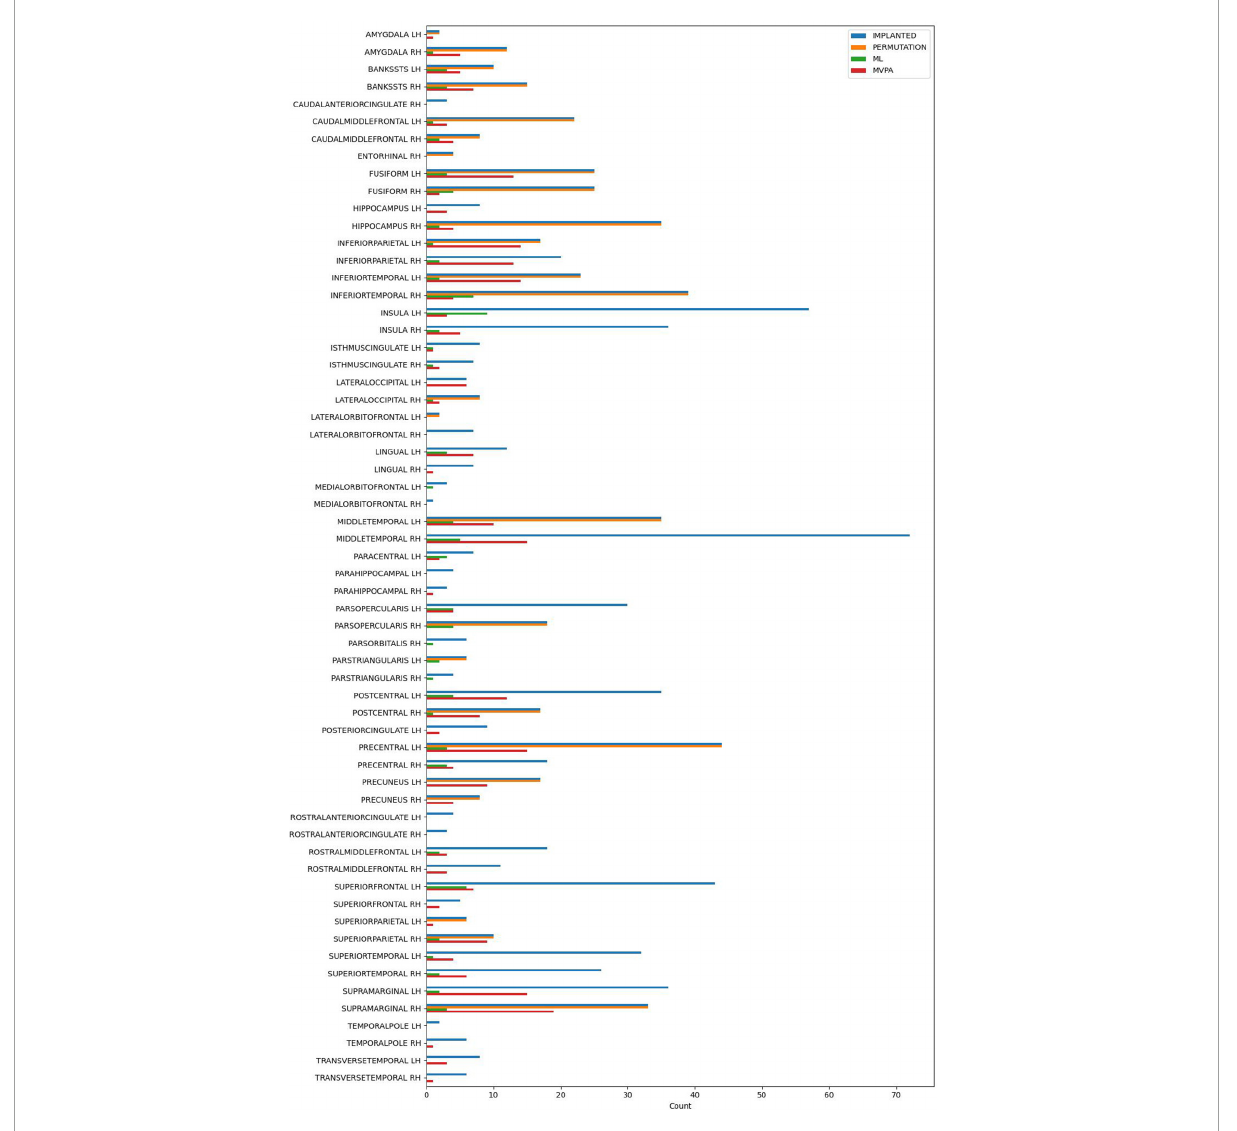
FIGURE3 The number of implanted electrode contacts, and the number of electrode contacts exhibiting significant contrast between conditions, per brain structure and analysis